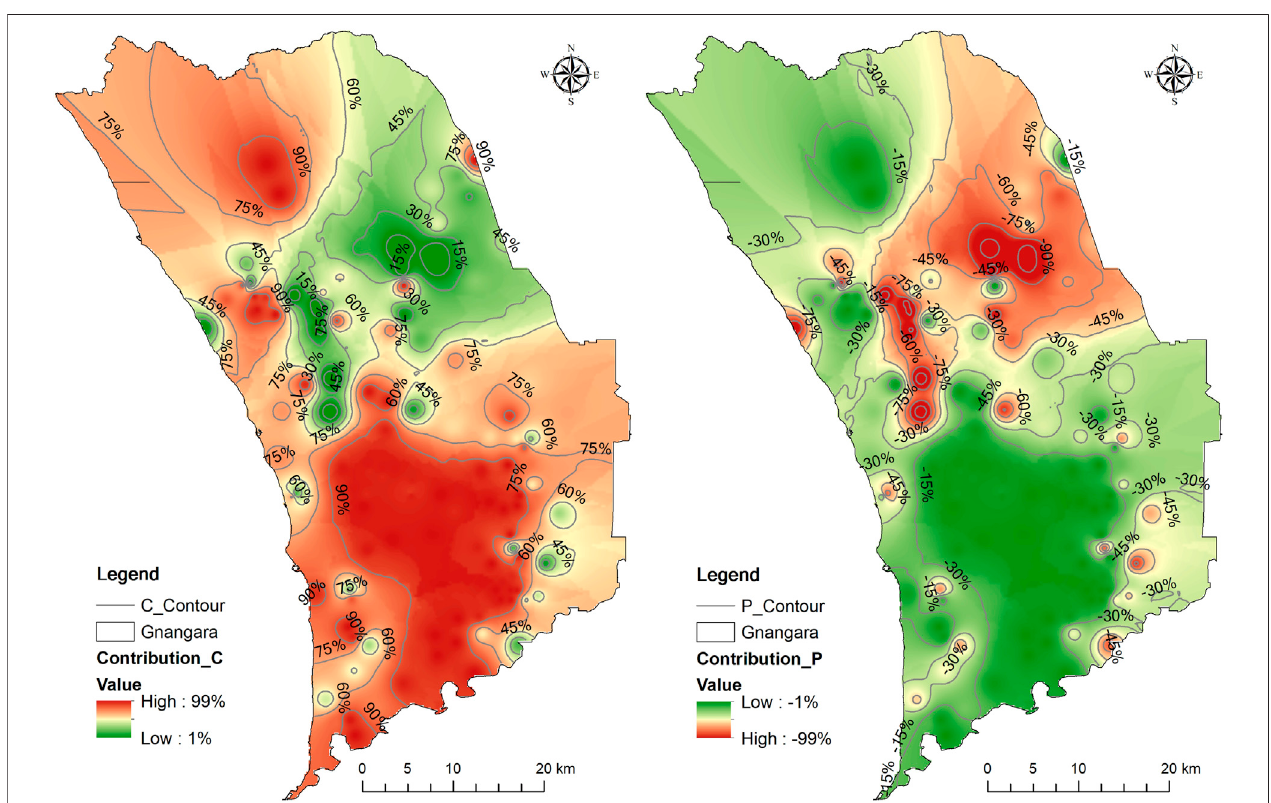
FIGURE 10 | Spatial distribution of the rainfall and pumping contributions to the groundwater level changes in the Gnangara region.